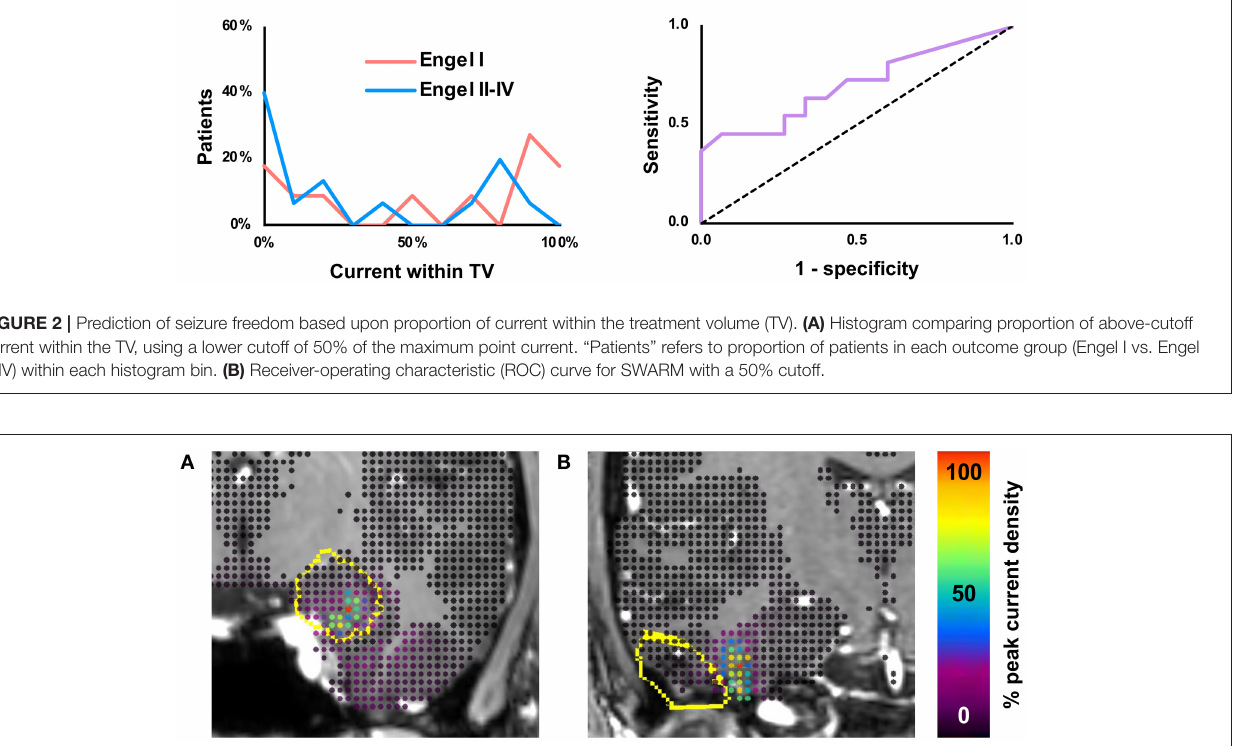
FIGURE 3 | Examples of true positive and true negative cases. (A) Engel class I outcome 2 years after laser ablation of amygdala and hippocampus including 92% of interictal current. (B) Engel class III outcome 2 years after resection of temporal pilocytic astrocytoma including 0% of interictal current. The treatment volume (dilated by 2mm to account for grid size) is outlined in yellow on coronal section from preoperative MRI. Current density is shown at each point in the gray matter grid. Proportions of current included in the treatment volume are based on the SWARM method with a lower cutoff value of 50% of the maximum point